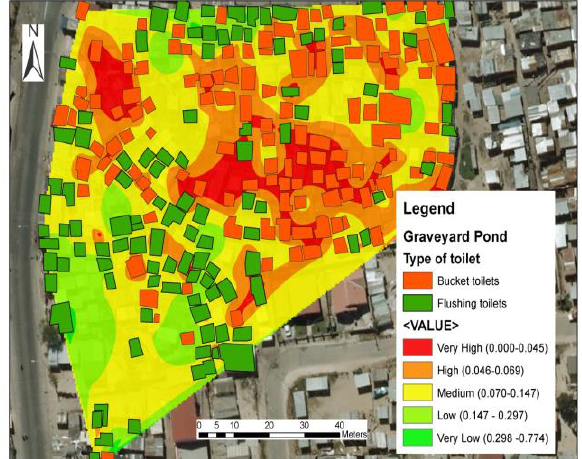
Figure 6. Vulnerability map showing the type of toilets used in Graveyard Pond relative to the prevalence of diseases (Musungu 2012: 67)